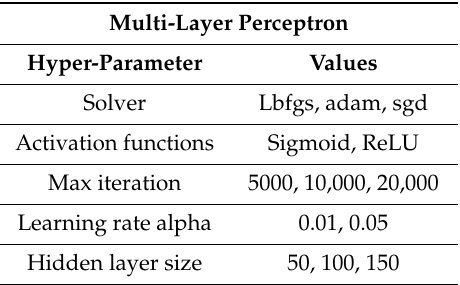
Table 12. Hyper-parameters of Multi-Layer